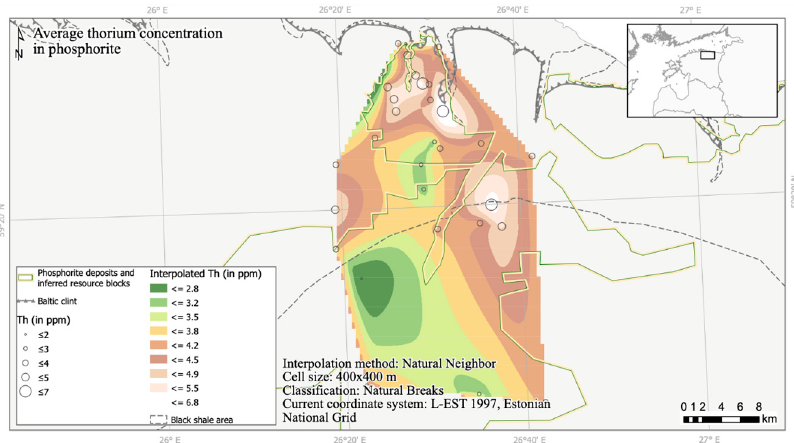
Figure 10. The distribution model of Th in the main phosphorite deposit areas.